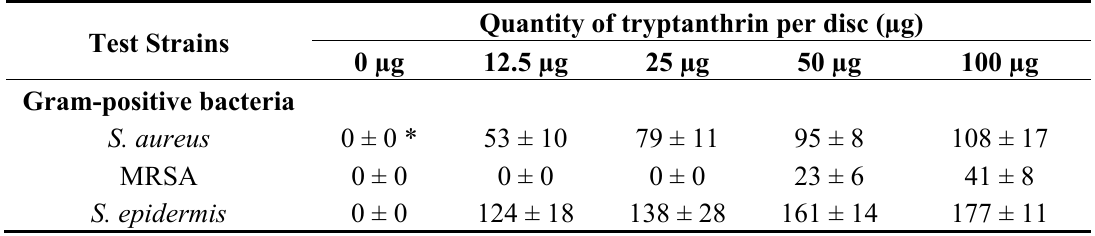
Table 4. The antimicrobial effect of tryptanthrin (Sigma) on tested microorganisms. Only the strains sensitive to the tryptanthrin are